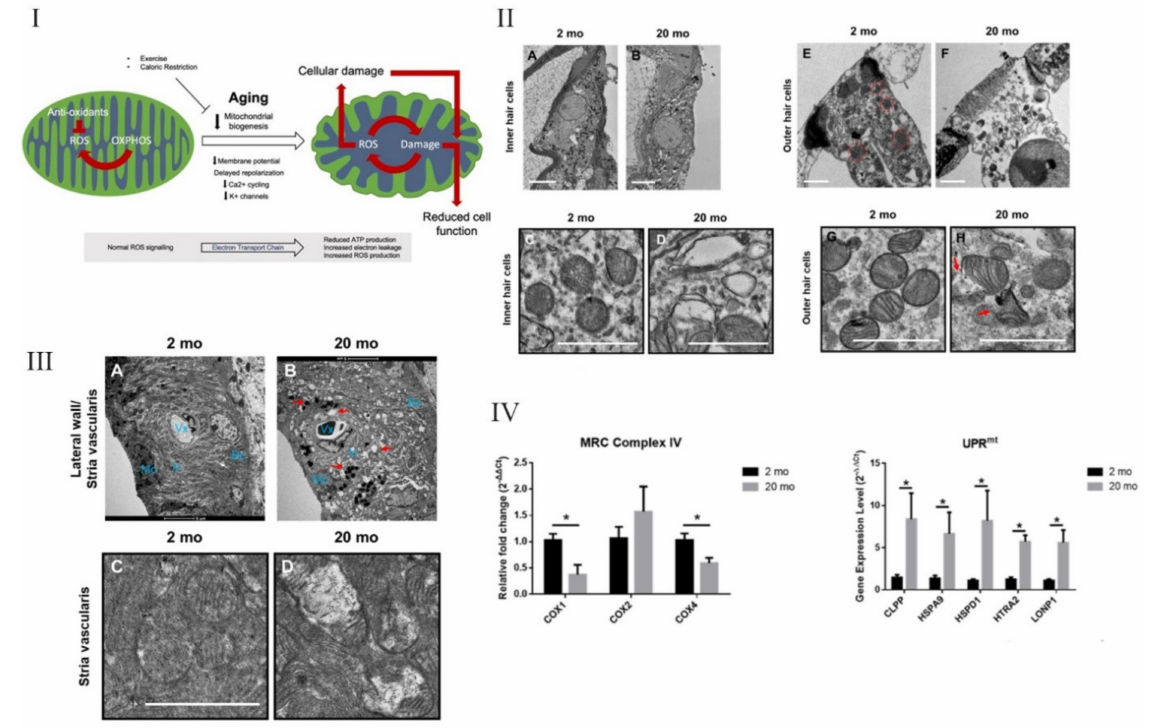
Figure 4. Mitochondrial changes within the aging cochlea. ( I ) Schematic drawing illustrating the production of ROS through regular oxidative (OXPHOS) activity. ROS production is normally kept under control via anti-oxidant systems; however, during aging, mitochondrial dysfunction accumulates and reduces ROS control. The resulting increase in ROS production causes cellular and further mitochondrial damage, leading to apoptosis. ( II ) ( A ) Young IHCs with normal appearing mitochondria with clear, distinct lamellar cristae ( C ). ( B ) Older IHCs with damaged mitochondria that have ( D ) missing or damaged cristae. ( E ) Young OHCs, also with ( G ) clear, well-defined lamellar cristae. ( F ) Older OHCs show aging effects on the mitochondria, such as swollen cells and chromatin compaction. ( H ) The cristae from the OHCs are distorted and show a broken wall. Scale of ( A , B ) is 5 µ m and ( C – H ) is 1 µ m. ( III ) ( A ) Transmission electron microscopy (TEM) images of young SV shows normal expression of marginal (mC), intermediate (Ic), and basal (Bc) cells, and the blood vessels (Vx). ( B ) An aged cochlea shows a degraded SV degeneration. This aging is depicted by an increase in vacuoles and pigmentation (red arrows), along with enlarged intercellular spaces. Scale for ( A , B ) is 5 µ m. ( C ) Young SV with normal mitochondria with well-defined cristae. ( D ) Aged SV showing marred mitochondria with altered cristae. Scale for ( C , D ) is 1 µ m. ( IV ) Gene expression changes in mitochondrial respiratory chain (MRC) complex IV significantly decrease with aging, while unfolded protein response (UPR) gene expression levels between young and old animals significantly increased (* p < 0.05). From Lyu et al. [159] and Strickland et al. [162], with permission from the